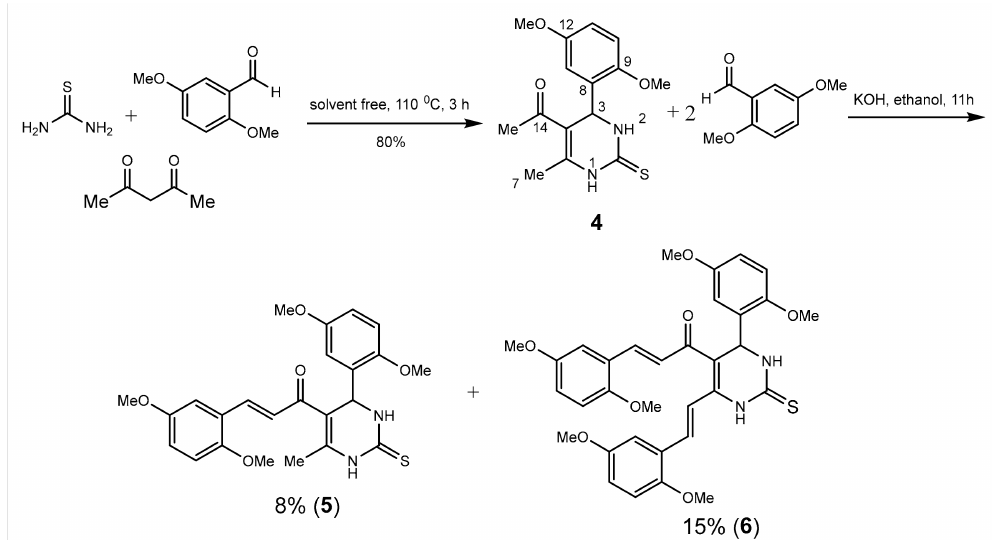
Figure 2. Synthesis reaction of the title